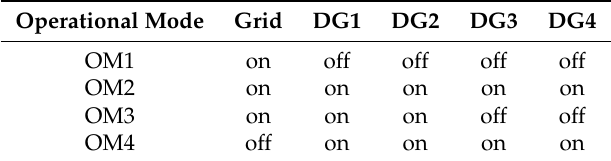
Table 2. Microgrid operational